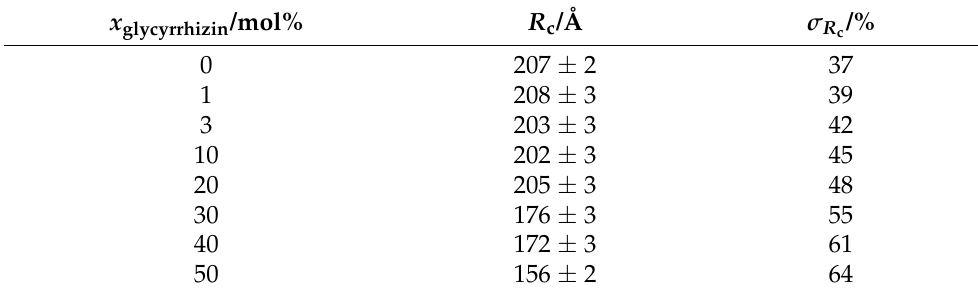
Figure 8. Flow chart showing the fitting procedure of equivalent SANS and SAXS data with the CMS model. Table 2. Core radii R c and corresponding polydispersities σ R applied to SANS data of samples with different x glycyrrhizin in D 2 O as solvent. Errors for R c result from the CMS fit with the program SASView [59] and seem to be underestimated in view of the high values of σ R c